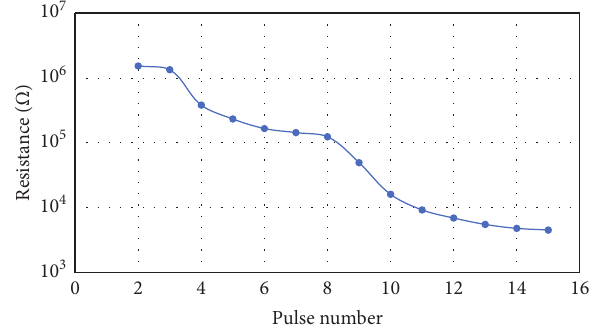
Figure 12: Pulse number vs. resistance curve of simulation